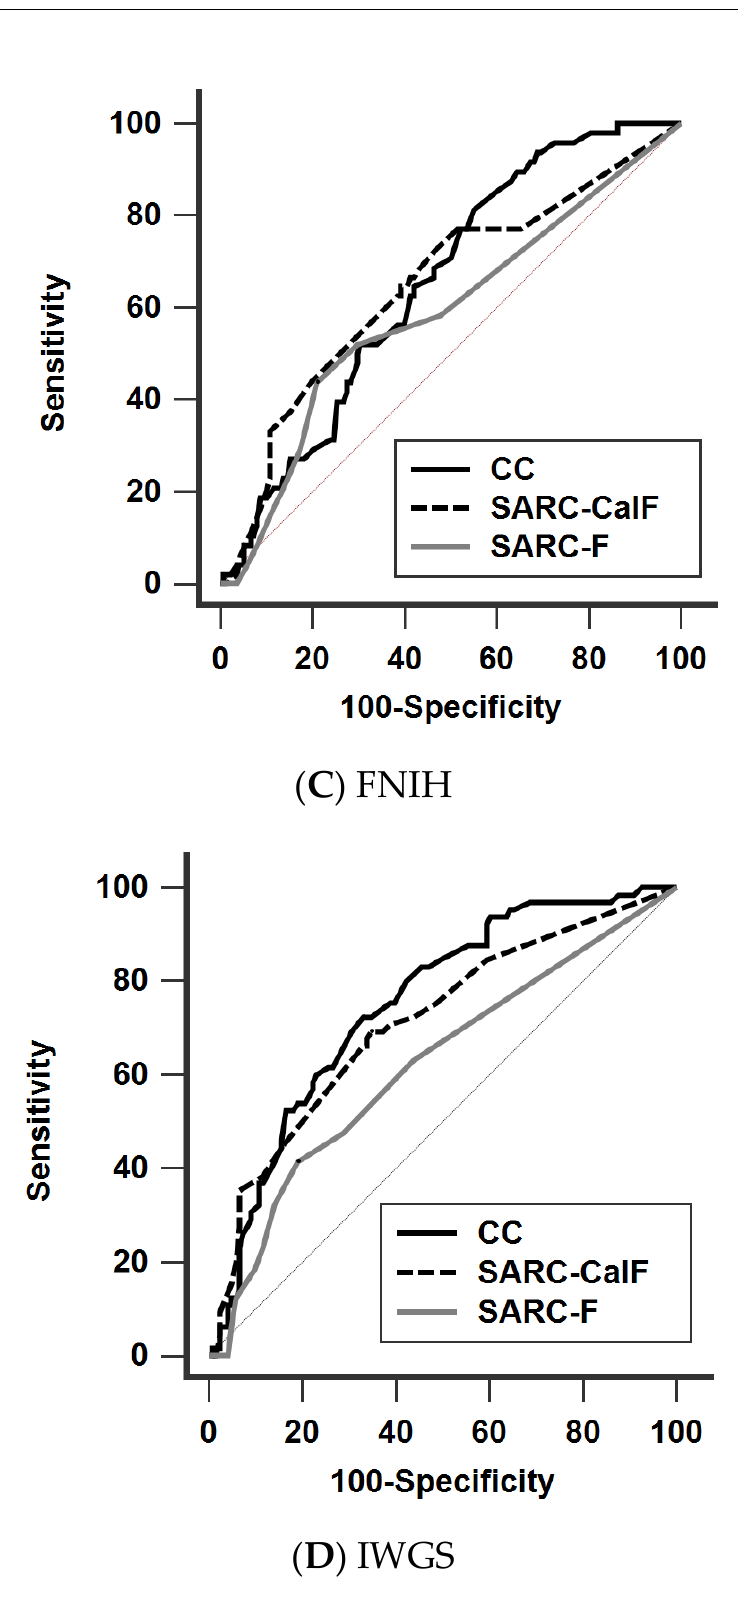
Figure 2. Receiver operating characteristic curves of SARC-F, SARC-CalF, and CC against the four different diagnostic criteria ( A ) AWGS 2019, ( B ) EWGSOP2, ( C ) FNIH, and ( D ) IWGS. AWGS, Asian Working Group for Sarcopenia; EWGSOP, European Working Group on Sarcopenia in Older People; FNIH, Foundation for the National Institutes of Health; IWGS, International Working Group on Sarcopenia, CC, calf circumference; SARC-F, strength, assistance walking, rise from a chair, climb stairs, and falls; SARC-CalF, SARC-F combined with calf